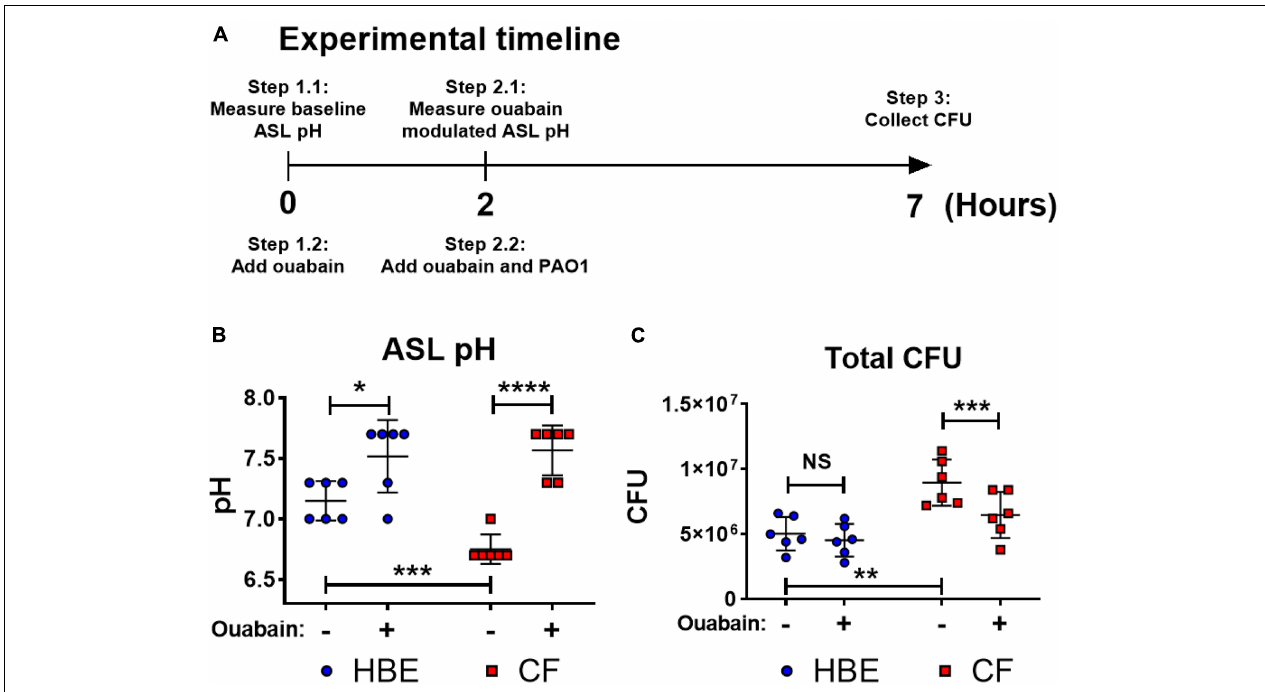
FIGURE 4 | Ouabain helps restore host defense activities by reversing the acidic pH to neutral pH in differentiated human bronchial epithelial cell cultures. (A) Experimental timeline. pH values were measured on the apical side of air-liquid interface cultured cells before and after 2 h of treatment with/without 20 µ M ouabain; PAO1 was then added to the apical side of cultured cells with ouabain or DMSO solvent control for additional 5 h. (B) Effect of ouabain treatment on pH values in non-CF (HBE) and CF epithelial cells. The change of pH in the epithelial apical wash was measured by narrow range pH test strips (pH 6–7.7, resolution 0.3 pH unit; n = 6). (C) Effect of ouabain treatment on P. aeruginosa CFU in non-CF (HBE) and CF epithelial cells. PAO1 was incubated on the apical side of cultured HBE and CF epithelial cells in the existence of 20 µ M ouabain or DMSO (solvent control). Biofilm and planktonic CFU were obtained by plated on agar plates for total PAO1 CFU ( n = 6). Data were collected from two independent experiments. Unpaired t -test was used for statistical analysis. Data are mean ± SEM. * p < 0.05; ** p < 0.01; *** p < 0.001; **** p < 0.0001; NS, not